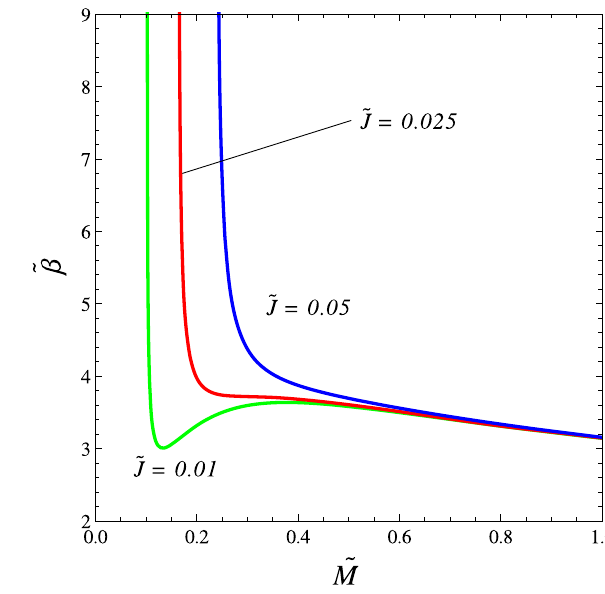
Fig. 15 Stability curves of β( M ) at fixed J for Kerr–AdS black holes in the microcanonical treatment. The curves of ˜ J = 0 . 01 (green), ˜ J = 0 . 025 (red), and ˜ J = 0 . 05 (blue) are plotted. No vertical tangent occurs in either case. The figure rotated by π clockwise represents the stability 2 curves of − M (β) at fixed J for the canonical ensemble, in which case the ˜ J = 0 . 01 (green) curve has two vertical tangents